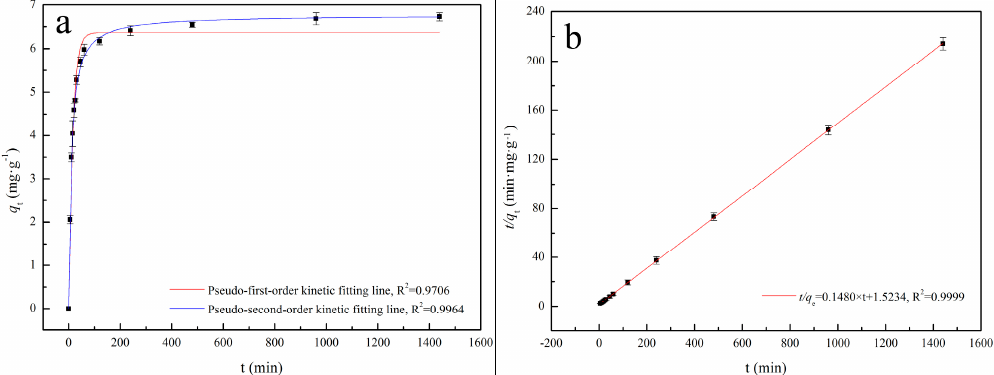
Figure 2. ( a ) Relation between Cd(II) adsorption amount and the contact time; and ( b ) the kinetic fitting line.